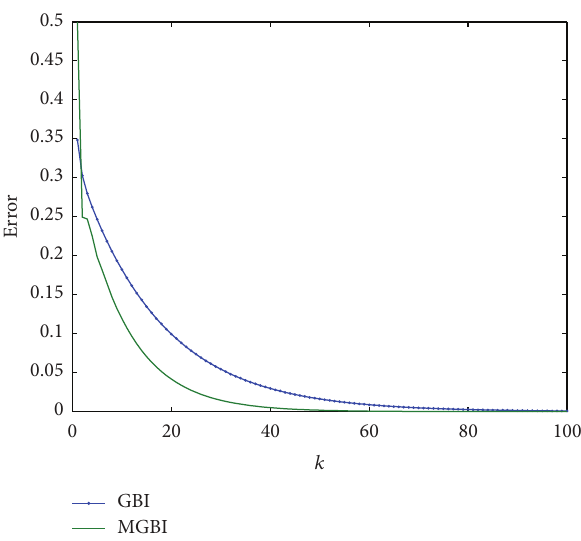
Figure 3: Comparison of convergence